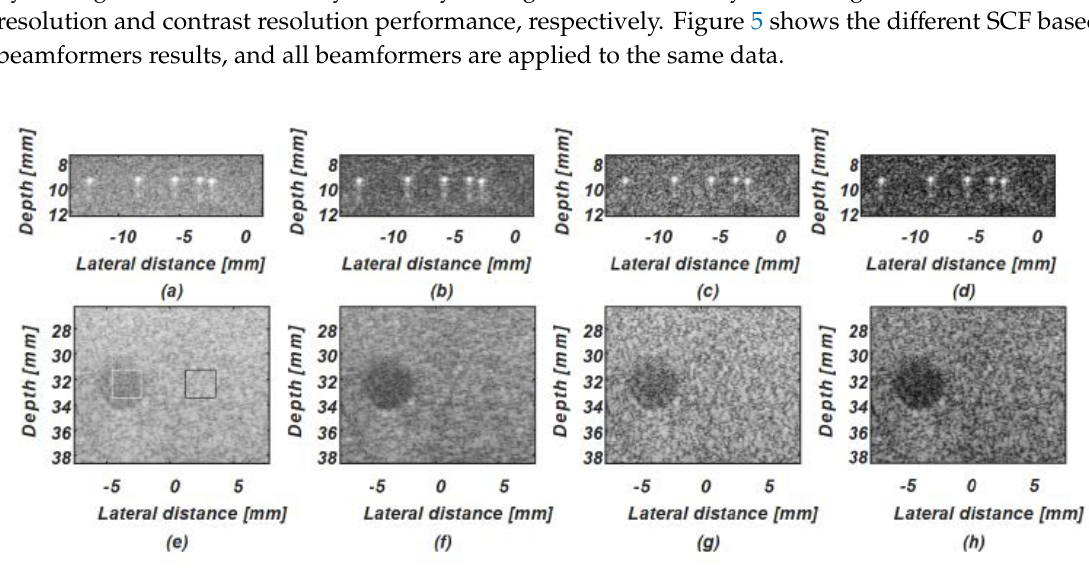
Figure 5. Experimental point targets and cyst images of different methods ( a ) ( e ) DAS, ( b ) ( f ) sSCF, ( c ) ( g ) aSCF, ( d ) ( h ) uSCF, All images are shown in a 70 dB dynamic range.